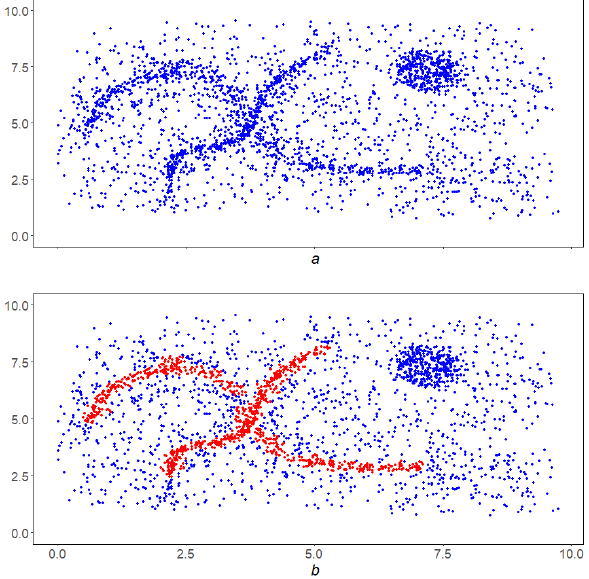
Figure 15. Operation of the LDPS algorithm. ( a ) The original array. ( b ) The linear structure indicated by red dots, built by the LDPS